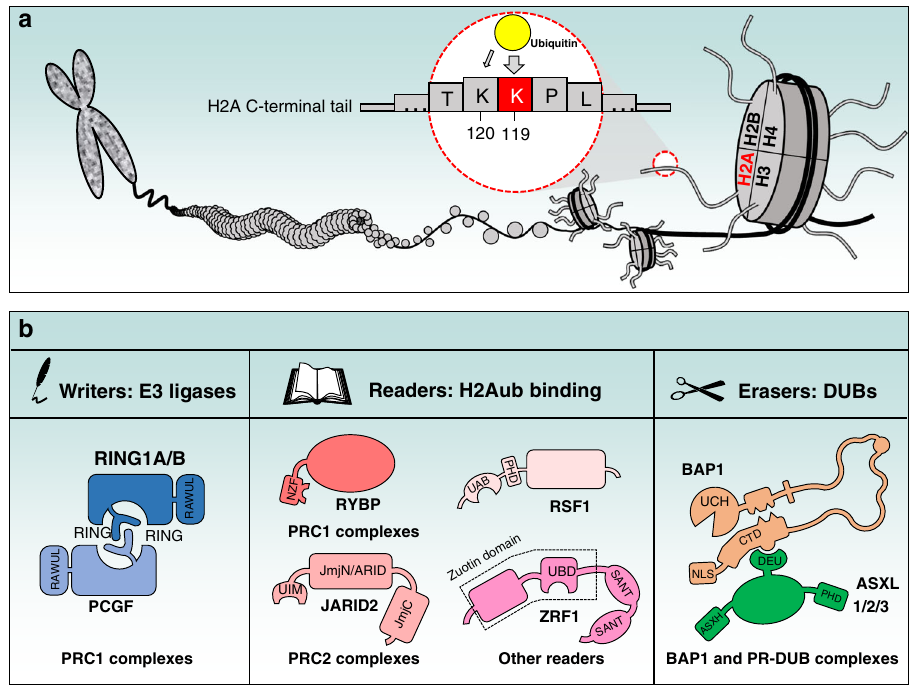
Fig. 1 Mammalian H2AK119ub (H2Aub) regulation by writers (ubiquitin E3 ligases), readers (ubiquitin-binding proteins) and erasers (deubiquitinases). a Schematic representation of chromatin and the mammalian H2AK119 ubiquitination site by PRC1 E3 ligase. Note that the mammalian H2AK120 site is a minor site for PRC1-mediated ubiquitination. b Schematic representation of known modulators of H2Aub. Important functional domains are indicated. RING: Really Interesting New Gene, UBD: Ubiquitin-Binding Domain, UIM: Ubiquitin Interaction Motif, NZF: Nuclear protein localization 4 Zinc Finger, UAB: Ubiquitin-Associated Domain, RAWUL: Ring- fi nger and WD40 associated Ubiquitin-Like, PHD: Plant Homeodomain, UCH: Ubiquitin C-terminal Hydrolase, CTD: C-Terminal Domain, NLS: Nuclear Localization Signal, DEUBAD (DEU): DEUBiquitinase Activating Domain, ASXH: HARE-HTH of